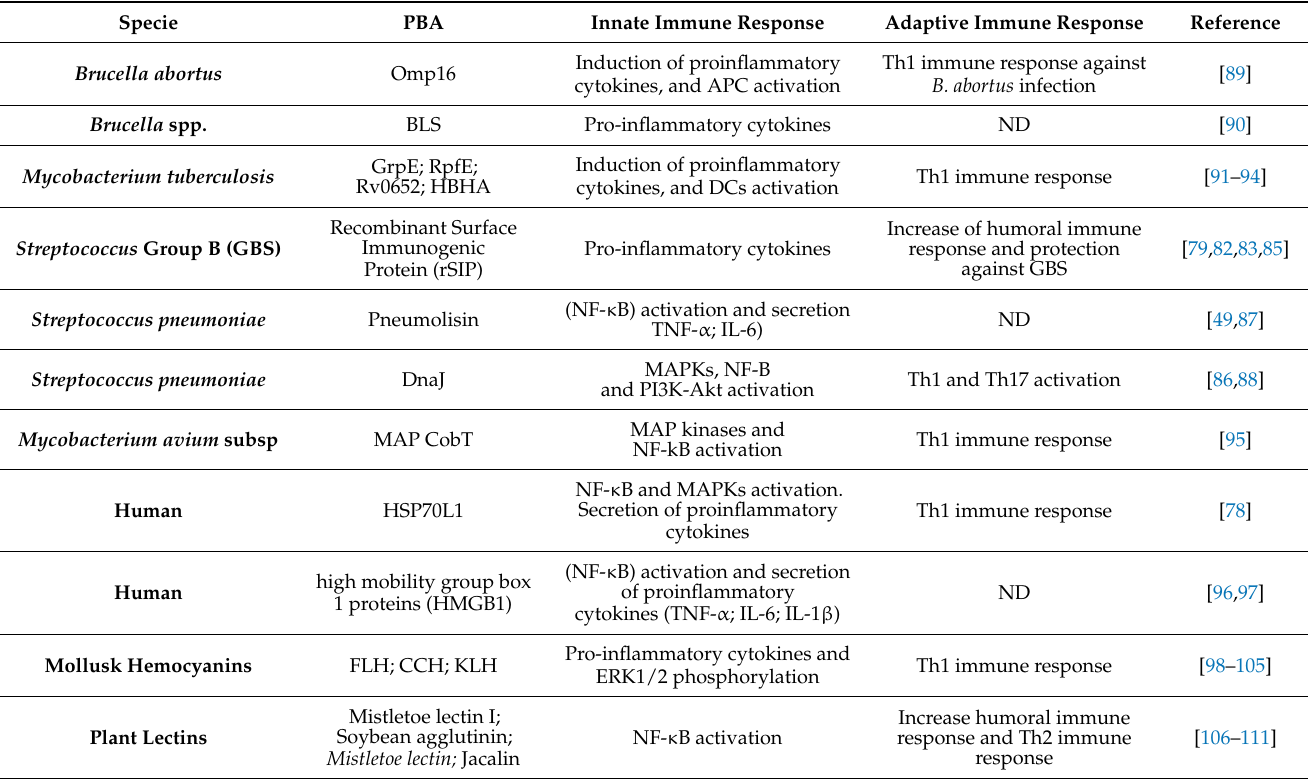
Table 3. PBAs from different organisms with TLR4 adjuvant